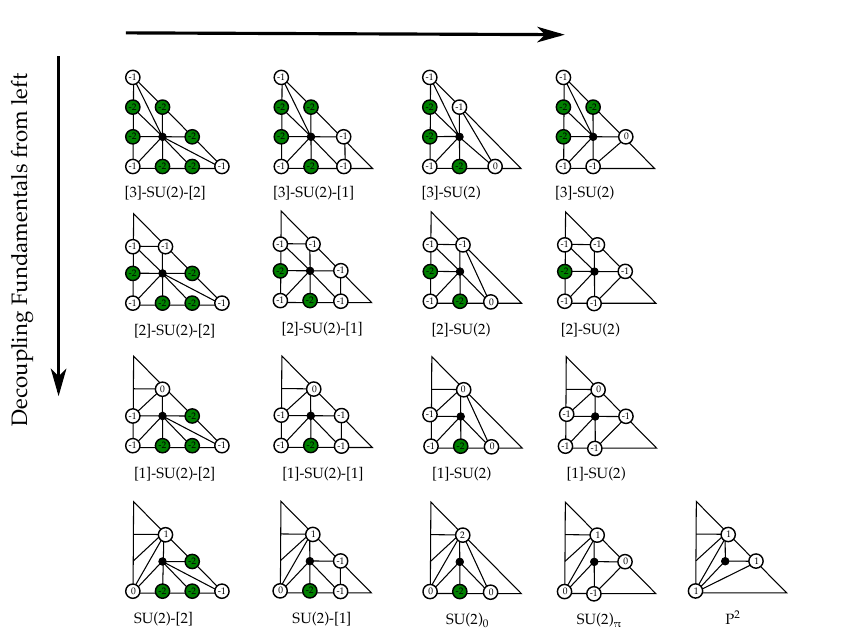
Figure 21 . CFD-transitions and decoupling for T 3 , which have a gauge-theoretic interpretation. The (cid:12)nal (cid:13)op is of course not realized in the gauge theory. Note also that there are further